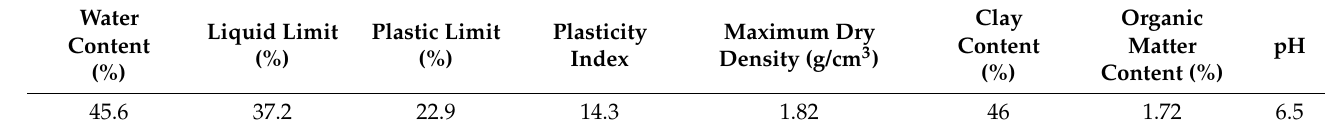
Table 1. Physical properties of recycled fine aggregate.